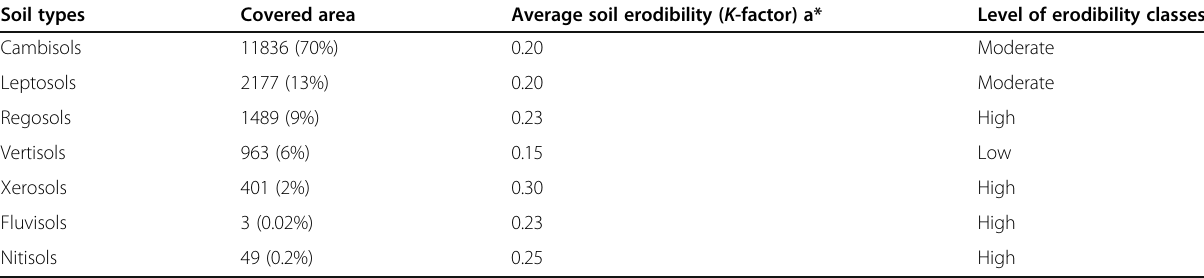
Table 4 Soil types area coverage and level of erodibility classes in relation to soil type erodibility ( K -factor) Soil